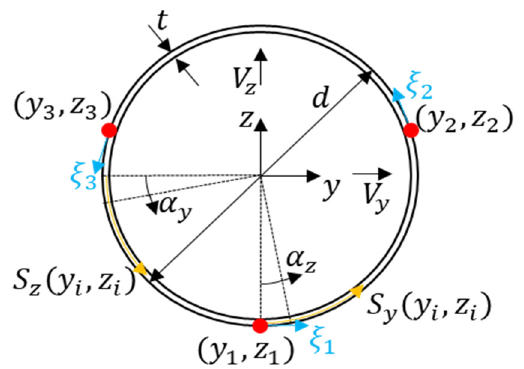
shown in Figure 5.